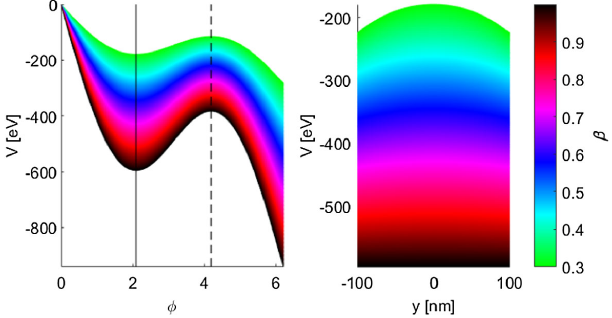
FIG. 8. The potential (Eq. (36) as function of φ and y at the synchronous phase indicated by the solid vertical line. The longitudinally unstable fixed point (dashed line) flips the sign of the transverse potential. The color scale indicates the adiabatic change of the potential with β